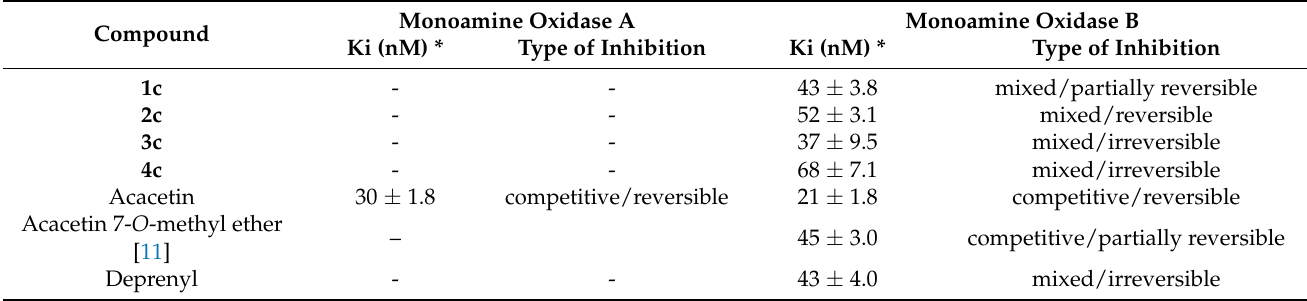
Table 3. Inhibition/binding affinity constant ( Ki ) values for inhibition of recombinant human MAO-B by modified